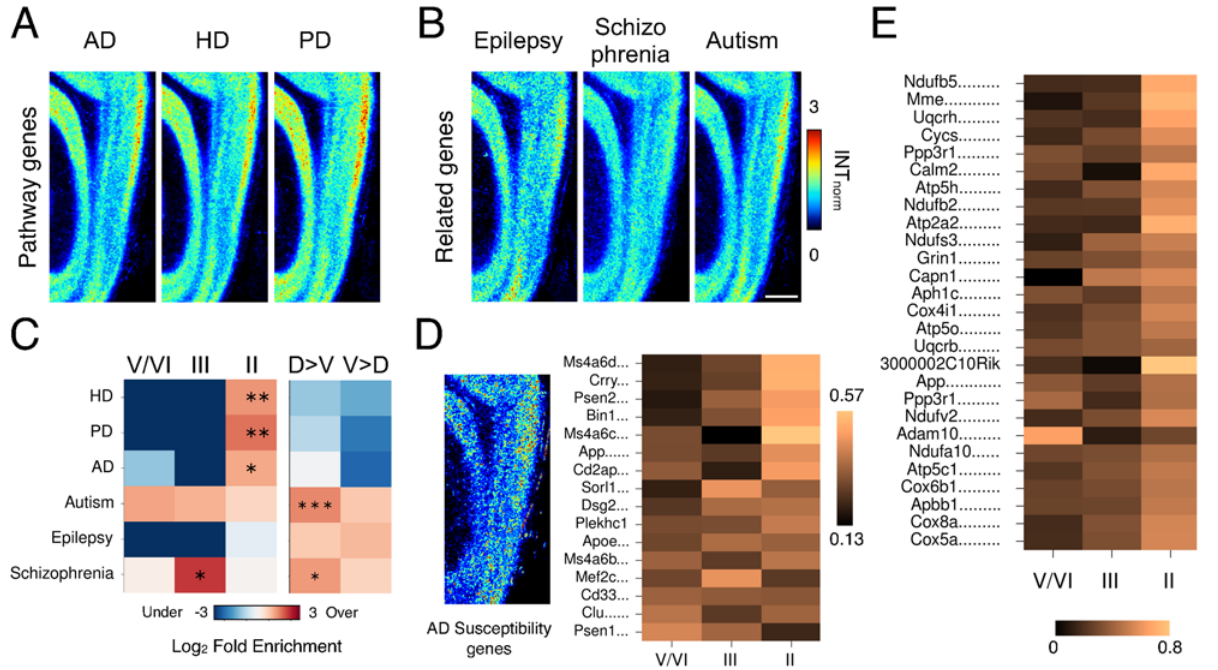
Figure 9. Laminar organization of disease-related molecular pathways. (A-B) Expression patterns of disease-related genes. Images show mean normalized pixel intensity (INT norm ) across all genes that are members of KEGG pathways associated with the indicated disorder (A) and genes linked to the indicated diseases (B). Pixel intensity values for each image were normalized to the mean pixel intensity of the MEC region prior to averaging. Scale bar 500 µ m. (C) Colors indicate log 2 fold enrichment of disease associations amongst layer-enriched genes (Number of enriched genes: LII:288, LIII:63, LV/ VI:152) (left) and amongst RNA-seq Cuffdiff 2-measured [58] significant (FDR < 0.05) D > V and V > D genes (right). Asterisks indicate FDR < 0.05 after a two-way Exact Fisher ’ s test followed by Benjamini-Hochberg correction for multiple testing. Schizophrenia-related genes are overrepresented amongst layer III-enriched genes (Log 2 Fold Enrichment = 2.22, p adj = 0.025) and both schizophrenia and autism-related genes are overrepresented amongst D > V genes (Schiz: 1.34, p adj = 0.013, Aut: 1.56, p adj = 6.1 × 10 -4 ). (D) AD susceptibility genes do not show laminar organization. Averaged image for AD susceptibility genes (left) [68 – 71] and heat maps representing the distribution of laminar expression (centre). Colors indicate the relative proportion of high-intensity ( (cid:1) 2 x mINT MEC ) pixels in each layer. (E) AD pathway genes show dominant layer II expression. Heat map colors indicate the relative proportion of high- intensity ( (cid:1) 2 x mINT MEC ) pixels in each layer for genes with at least moderate laminar enrichment.